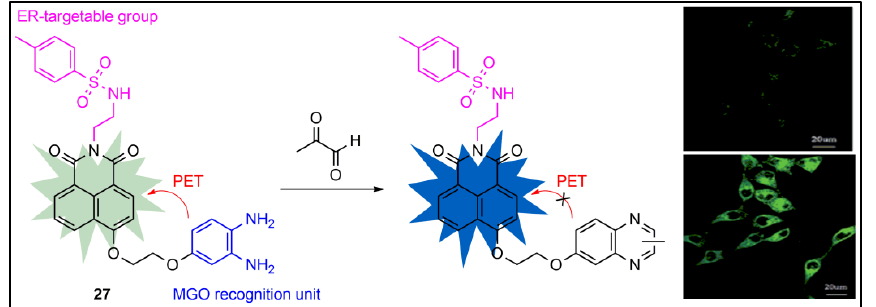
Figure 26. The recognition mechanism of 27 towards MGO. Confocal fluorescence images for monitoring exogenous MGO. HeLa cells were incubated first with 27 (10 mM), then with different concentrations of MGO — 0 μ M, (control, upper panel) and 50 μ M (lower panel) for 2 h ( λ EX = 405 nm, collected at 420-480 nm). Adapted with permission from [99]. Copyright (2018) The Royal Society of Chemistry.